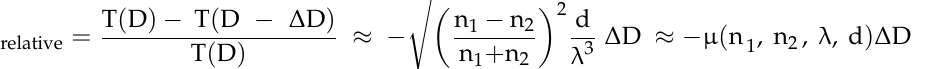
Figure 8. Predicted versus observed transmission of all individual data points. Predicted transmission was calculated using Equation (12). For reasons of clarity, only every 50th data point is shown. The red area corresponds to the error range based on Equations (13) and (21). Transparency of a healthy cornea is indicated at T = 85%.